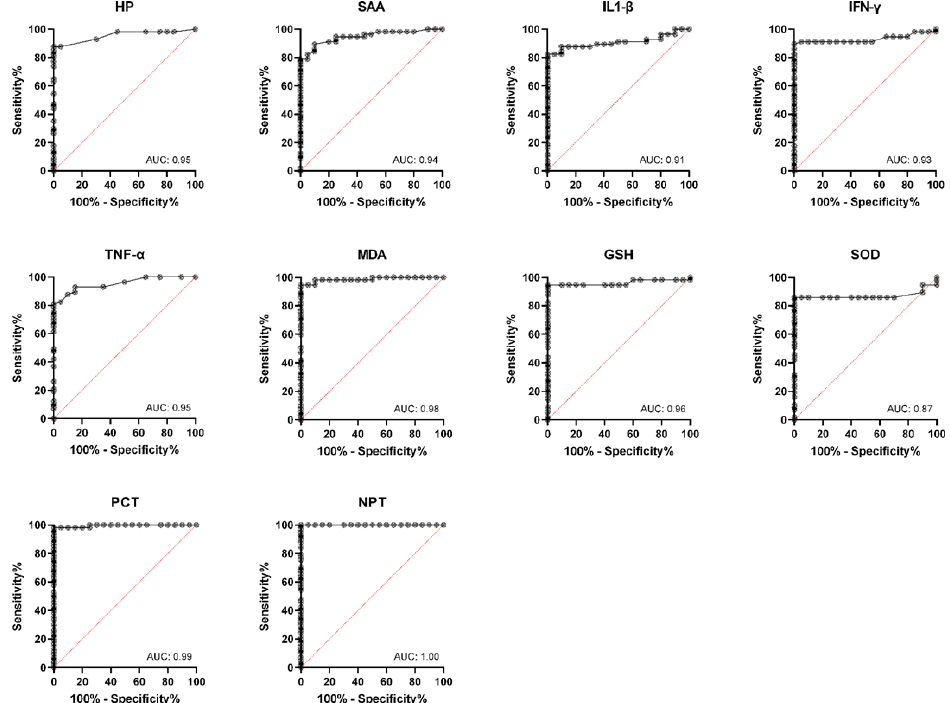
Figure 5. Receiver operating characteristic (ROC) curves for 10 selected blood biomarkers in diarrheic calves naturally infected with C. parvum and healthy control calves.